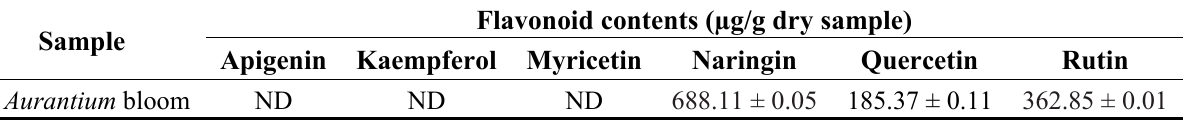
Table 3. Flavonoid compounds of methanolic extract of Citrus aurantium